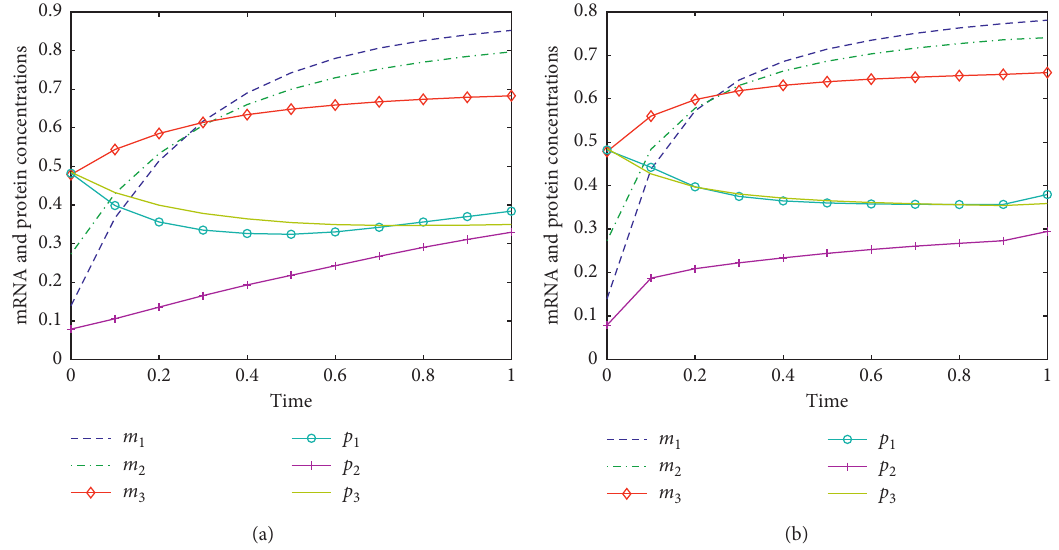
Figure 5: Transient states of DFGRN (66) with (a) q � 0 . 95 and (b) q � 0 . 6.